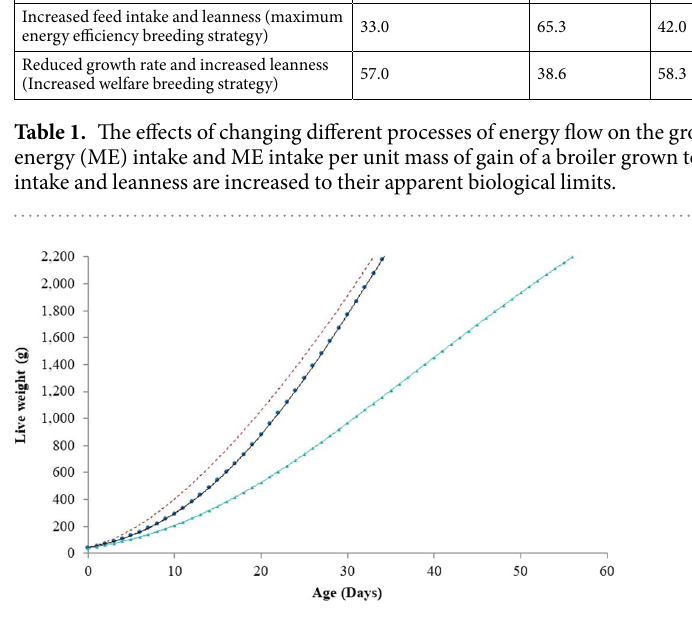
Figure 2. The growth rate of a current fast-growing broiler ( ) and the potential growth rate of future birds as defined by the different scenarios accessed; maximum energy efficiency (broken line) and increased welfare scenario (